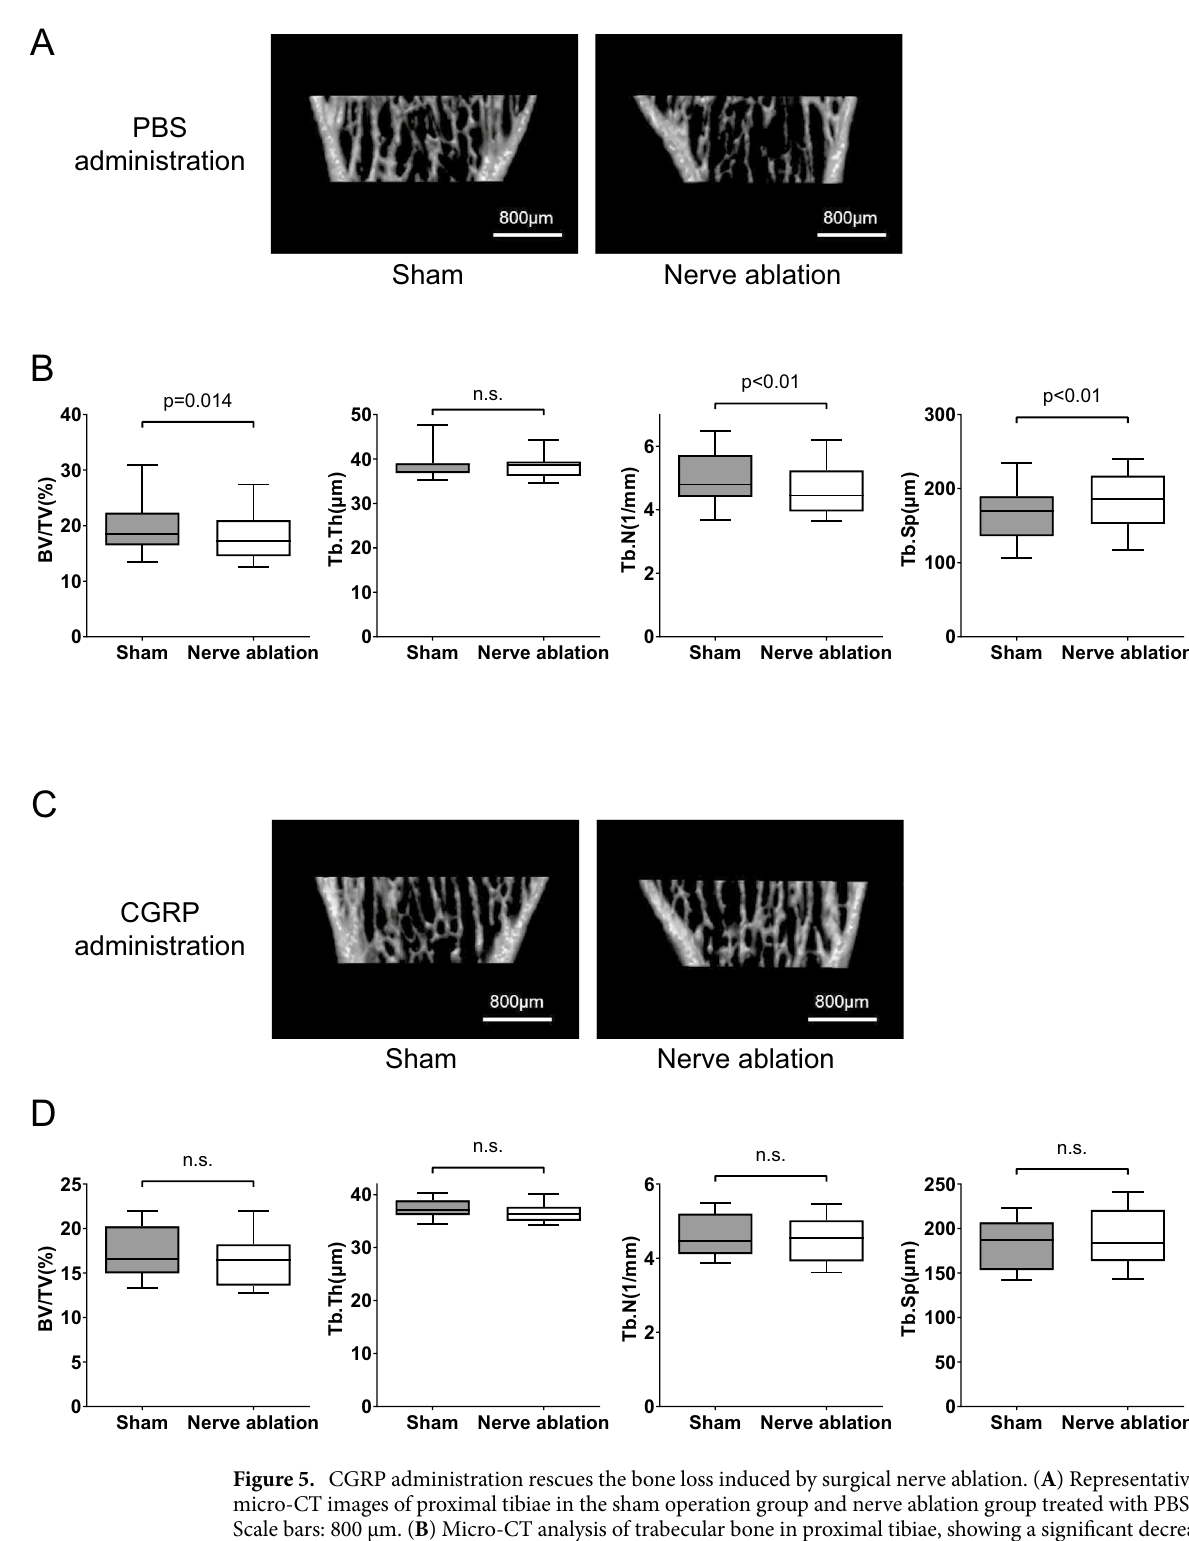
Figure 5. CGRP administration rescues the bone loss induced by surgical nerve ablation. ( A ) Representative micro-CT images of proximal tibiae in the sham operation group and nerve ablation group treated with PBS. Scale bars: 800 µm. ( B ) Micro-CT analysis of trabecular bone in proximal tibiae, showing a significant decrease in bone mass and trabecular number in the nerve ablation group treated with PBS. ( C ) Representative micro-CT images of proximal tibiae in both groups treated with CGRP. Scale bars: 800 µm. ( D ) Micro CT analysis of trabecular bone in proximal tibiae, showing that the bone loss caused by nerve ablation was rescued by CGRP administration. All data are presented as the means ± SEMs (n = 15). n.s.: not significant. P values were obtained using a two-tailed paired t test ( B and D